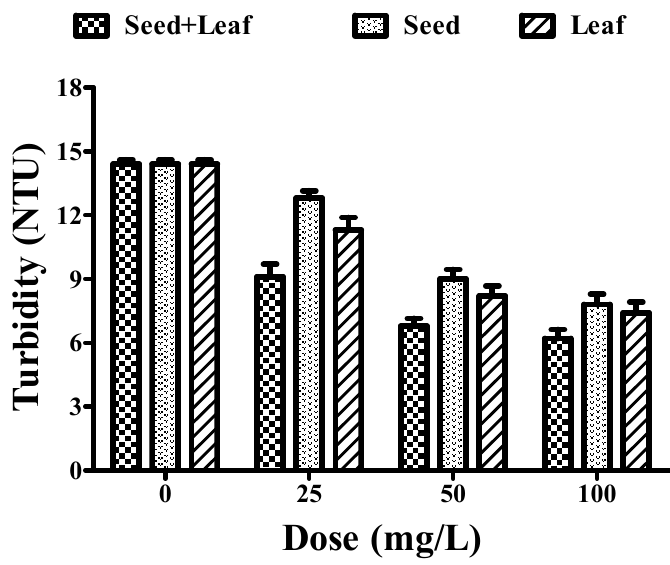
Figure 4. Comparative experimental analysis of the combined (seed and leaf) and individual extracts of the Moringa oleifera plant on turbidity parameters of groundwater at different doses (25–100 mg/L). All the experiments were done three times in triplicates and presented as mean ± SEM; NTU: Nephelometric Turbidity Unit.